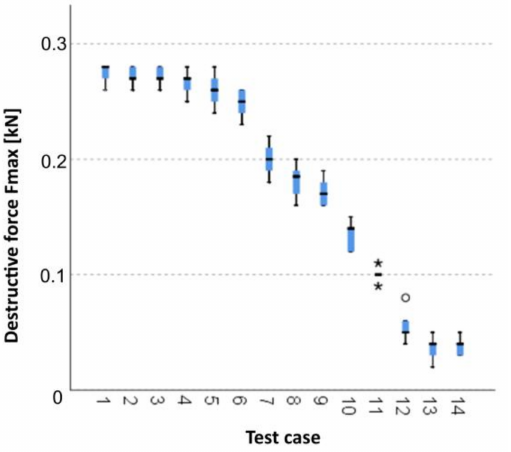
Figure 17. Graphic presentation of the Kruskal–Wallis test results for independent samples of the breaking force F max